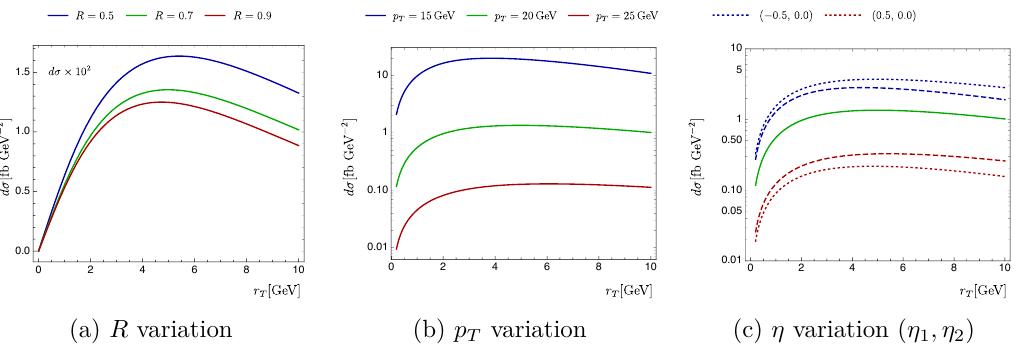
Figure 3. Impact of the variation of the jet radius ( R ), hard scale jet transverse momentum ( p ) and jet pseudorapidity ( η ) for dijet production. For pseudorapidity variation legend is shown T i referring to ( η ) pair, dashed and dotted lines correspond to negative and positive rapidity 1 , η 2